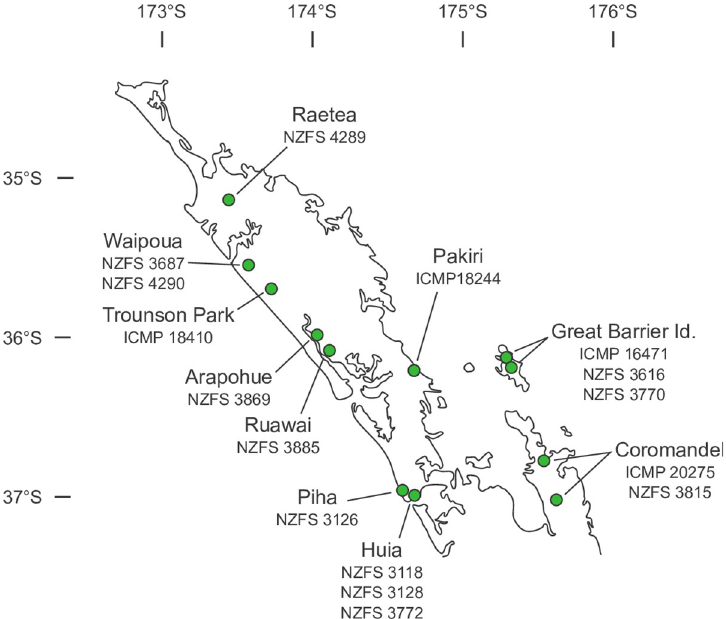
Fig 1. Map of the northern North Island of New Zealand showing collection locations for sampled Phytophthora agathidicida accessions. Base map used under a CC BY license, with permission from Free Vector Maps, original copyright 2014.